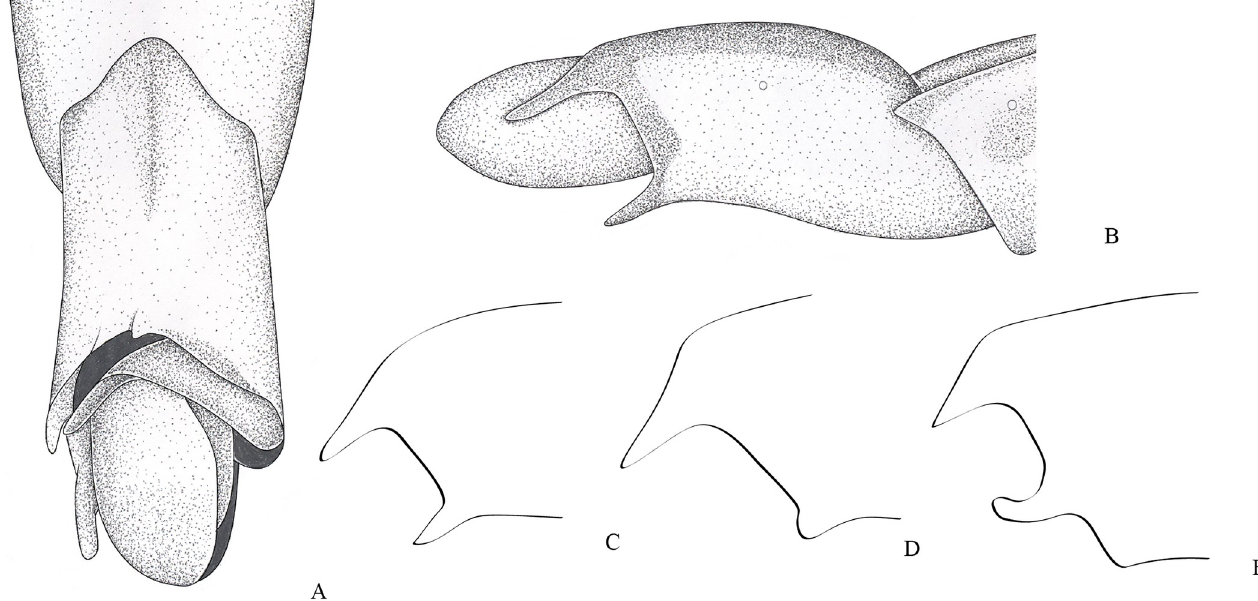
Fig 9. Potamobates sumaco . (A) Male, terminalia, dorsal view; (B) male, terminalia, right lateral view; (C-E) Variation of projections on the right posterolateral margin of male abdominal segment.